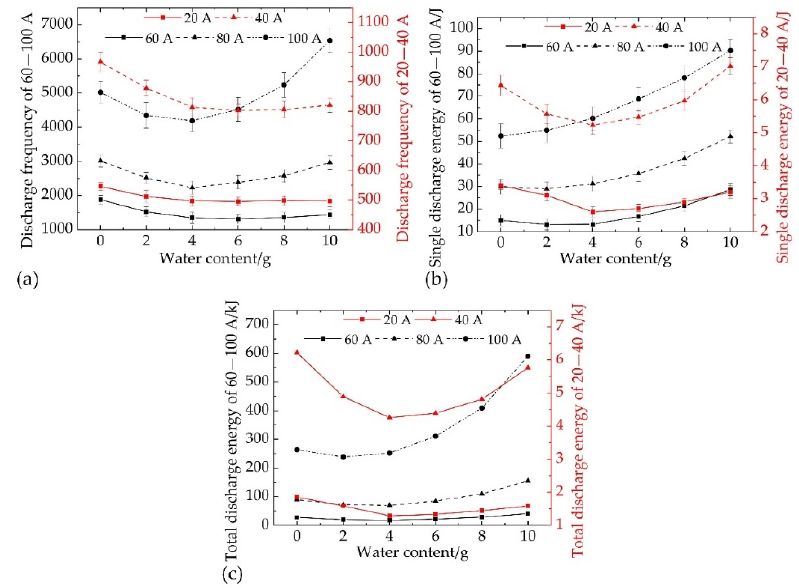
Figure 7. Effect of water content on arc discharge of C-Cu contacts: ( a ) discharge frequency; ( b ) average single discharge energy; ( c ) total discharge energy.